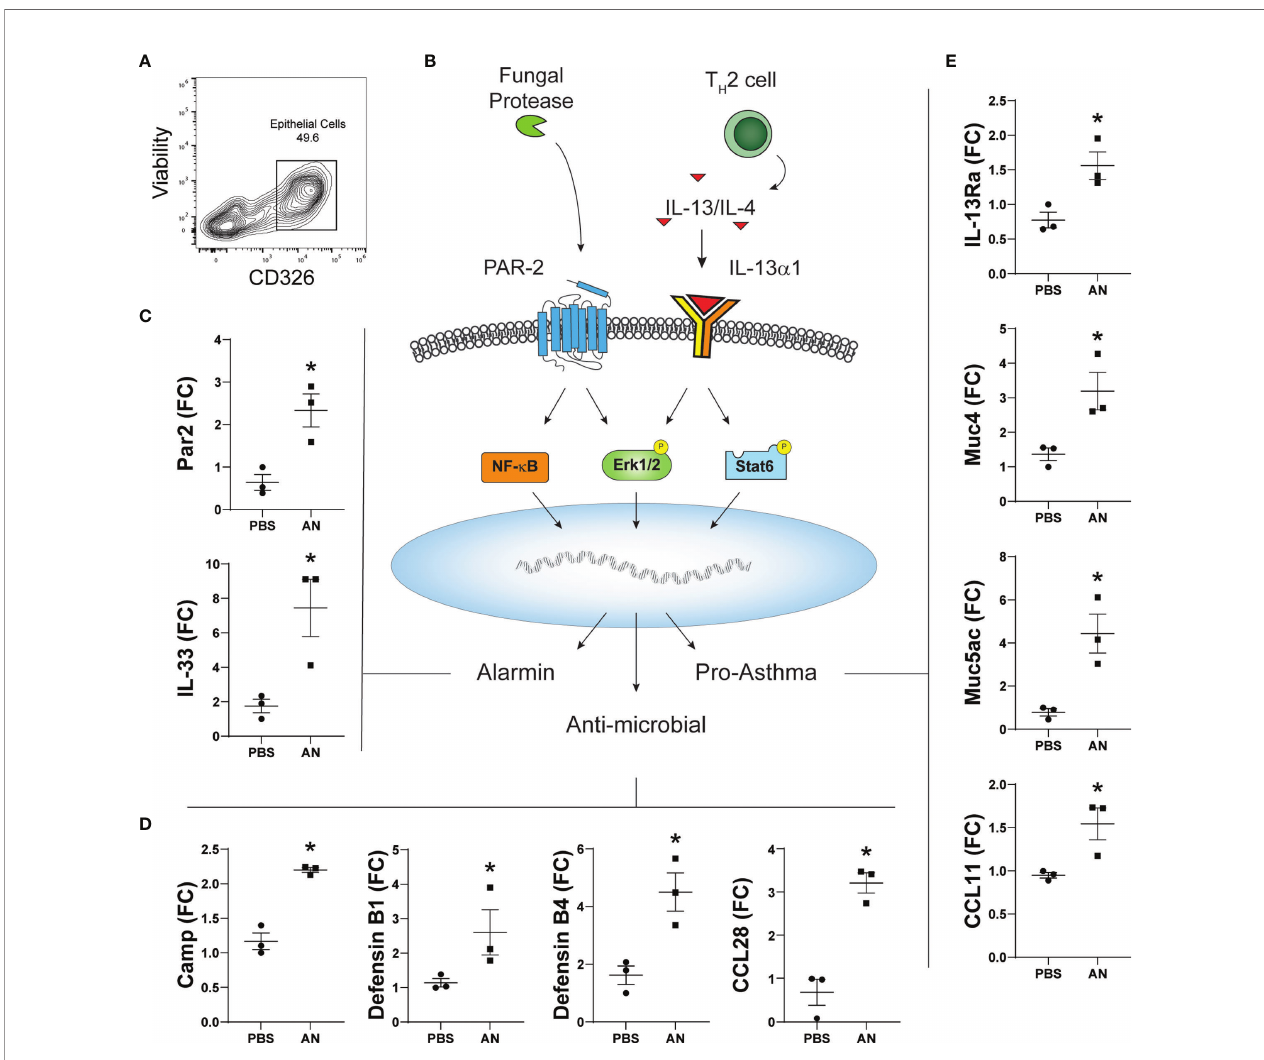
FIGURE 6 | Chronic airway mycosis promotes sinus epithelial cell alarmin, anti-microbial, and pro-asthma gene expression. (A) EpCam-positive (CD326+) epithelial cells were sorted from mice chronically challenged with 4 × 10 5 A. niger (AN) or PBS every other day for 2 months for gene expression. (B) Diagram of relevant epithelial responses to fungal protease and Th2-driven in fl ammation. Protease activates protease activated receptor 2 (PAR-2) signaling to NF- k B and Erk1/2 to induce (C) alarmin and (D) antimicrobial gene expression. TH2 cytokines IL-13 and IL-4 signaling through IL-13R a 1 activate Erk1/2 and Stat6 to promote (E) pro- asthma gene expression. * p < 0.05, n = 3 by Student ’ s t